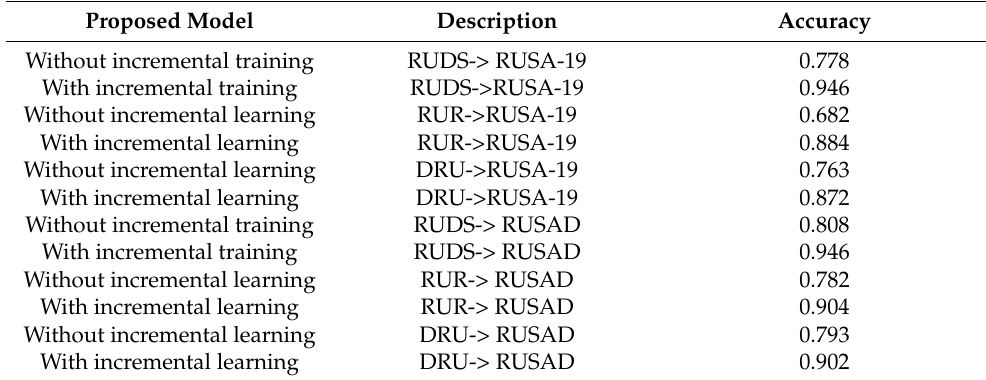
Table 8. Accuracy of the proposed model with transfer learning on target domains.